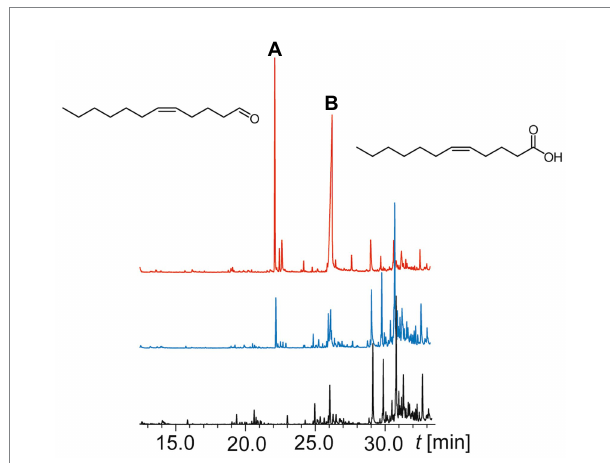
FIGURE 2 Total ion chromatograms of a GC/MS analyses of two outer membrane vesicle extracts (blue and red upper traces) and a control sample of the medium (black lower trace). Compounds A and B and their structures are